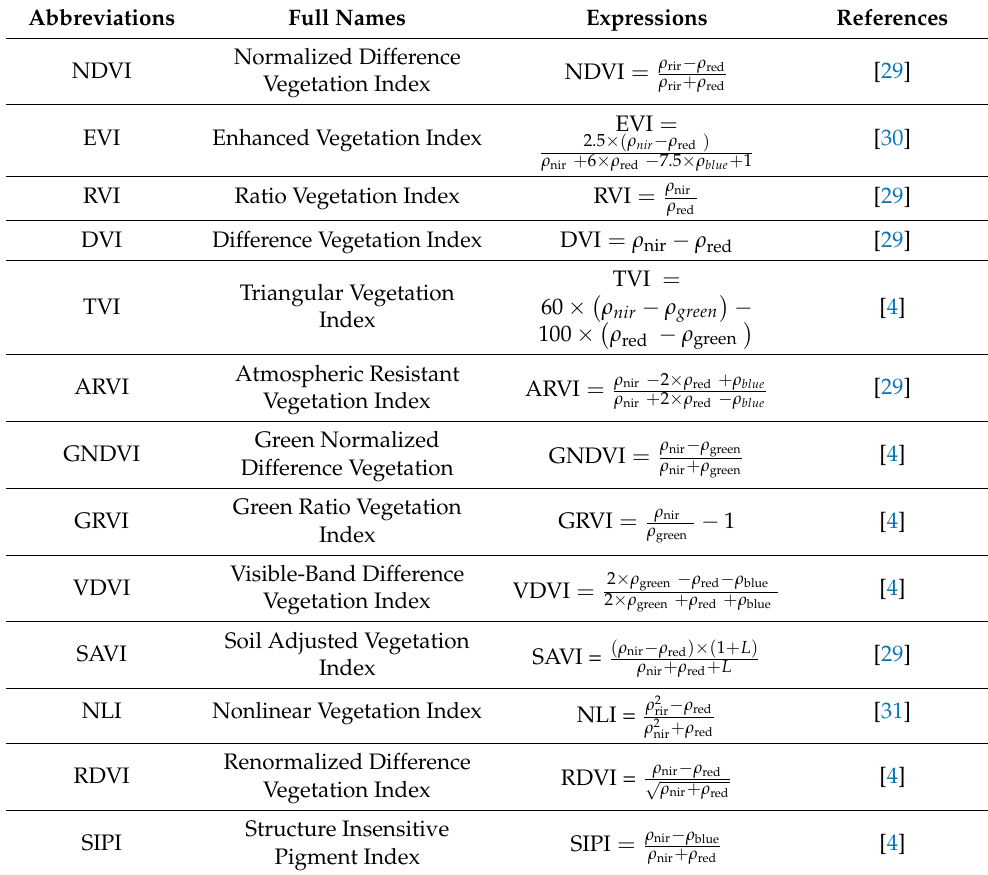
Table 5. Vegetation indexes for corn lodging